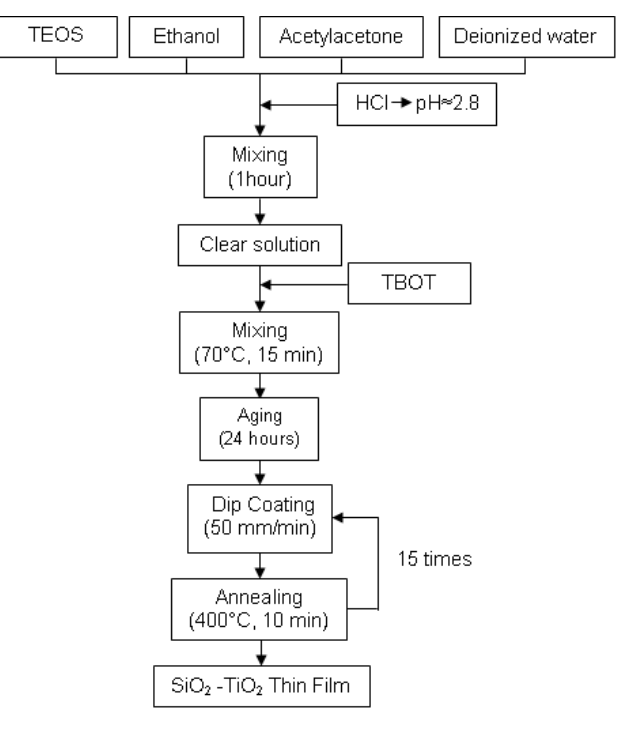
–TiO thin film 2 2